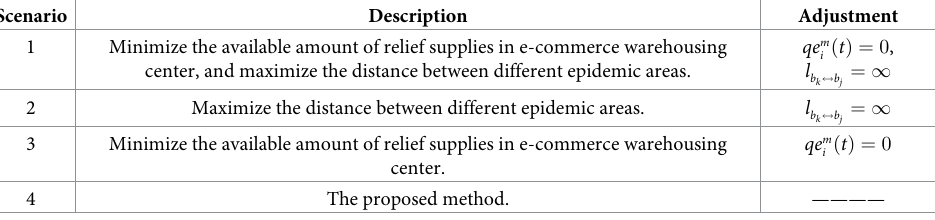
Table 1. Parameter adjustment of different